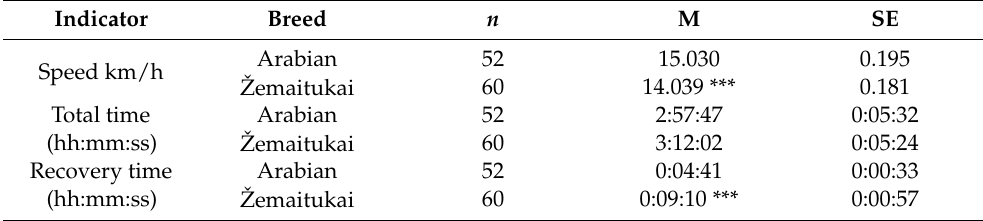
Table 3. Speed and recovery time by breed after 45 km